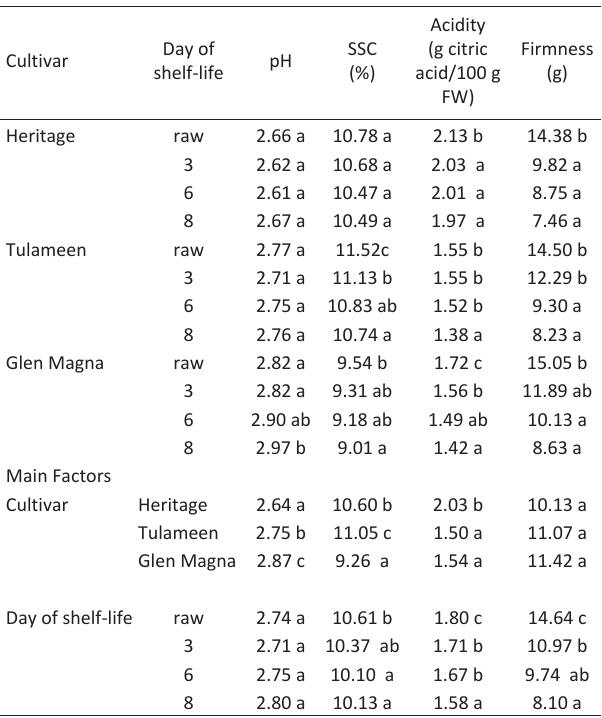
Different letters indicate significant differences among the days of shelf-life of the same cultivar or among the main factors (Tukey test).